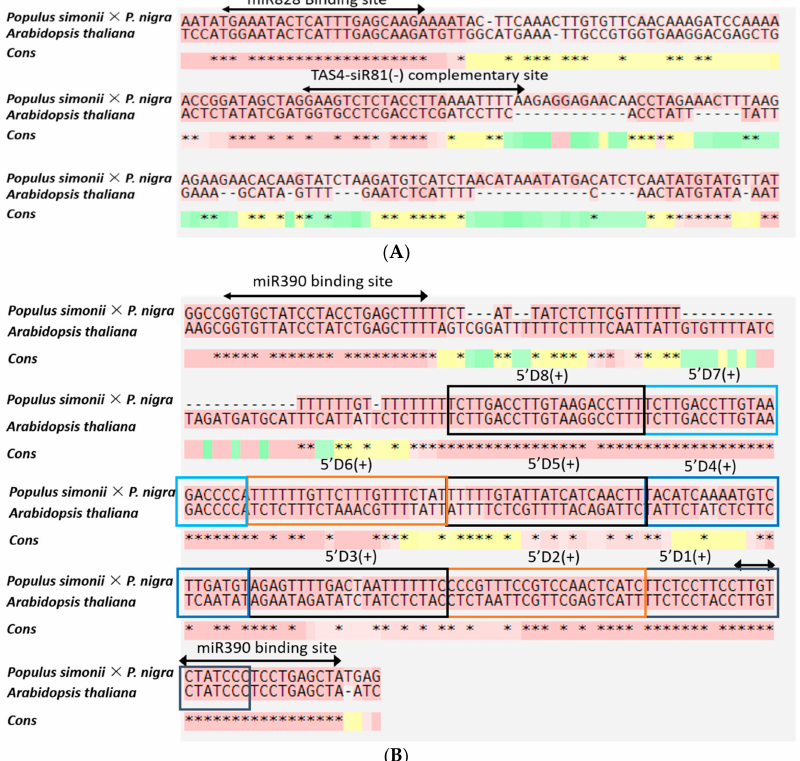
Figure 2. Sequence alignment of putative TAS3 and TAS4 paralogs in Populous simonii × P. nigra and Arabidopsis thaliana (Black arrow shows the complementary site of TAS4-siR81 ) ( A ) and the binding site of miR390 ( B ) miR828. Boxes indicate phased ta-siRNA and sequences of 5 (cid:48) D1( + ) to 5 (cid:48) D8( + ) that are proved in Arabidopsis